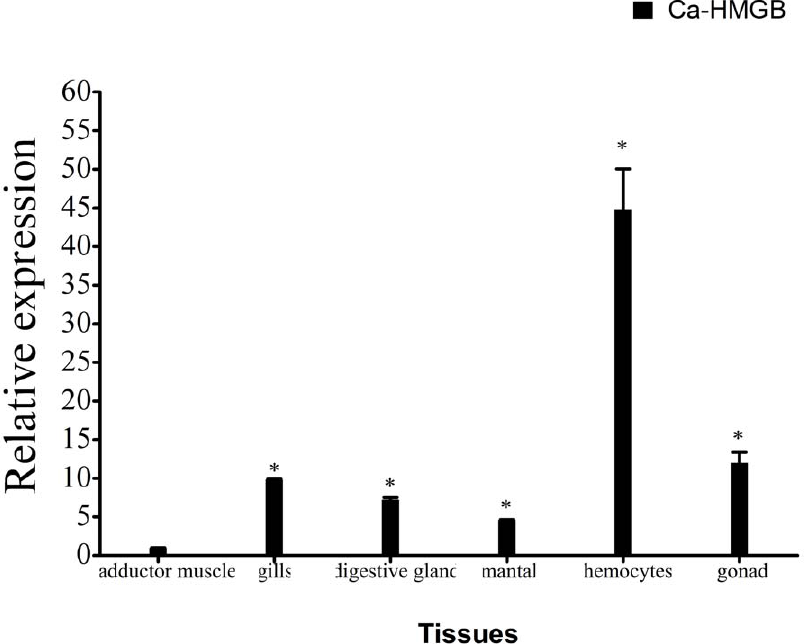
Figure 3. Expression levels of Ca-HMGB were detected in various tissues by real-time RT-PCR. The data were normalized by mRNA expression in the adductor muscle and 28s rDNA was used as endogenous control. The values were presented as mean 6 SEM of independent experiments done in triplicates and analyzed by Student’s t-test. *p # 0.05 when compared to control value.